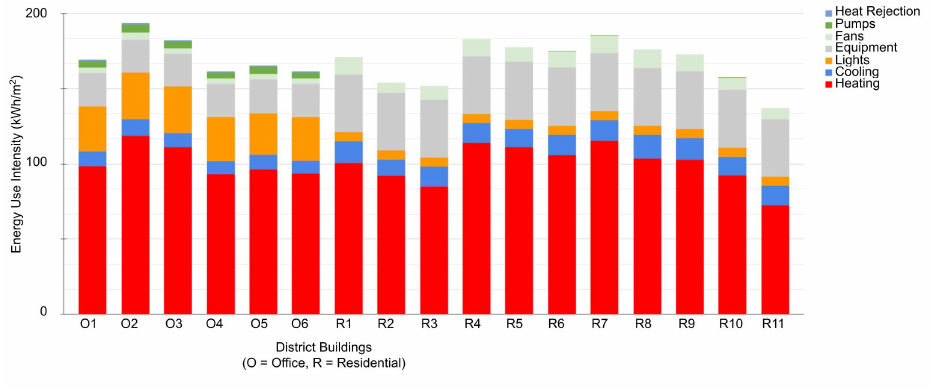
Figure 12. ASHRAE 90.1 Appendix G systems energy simulation